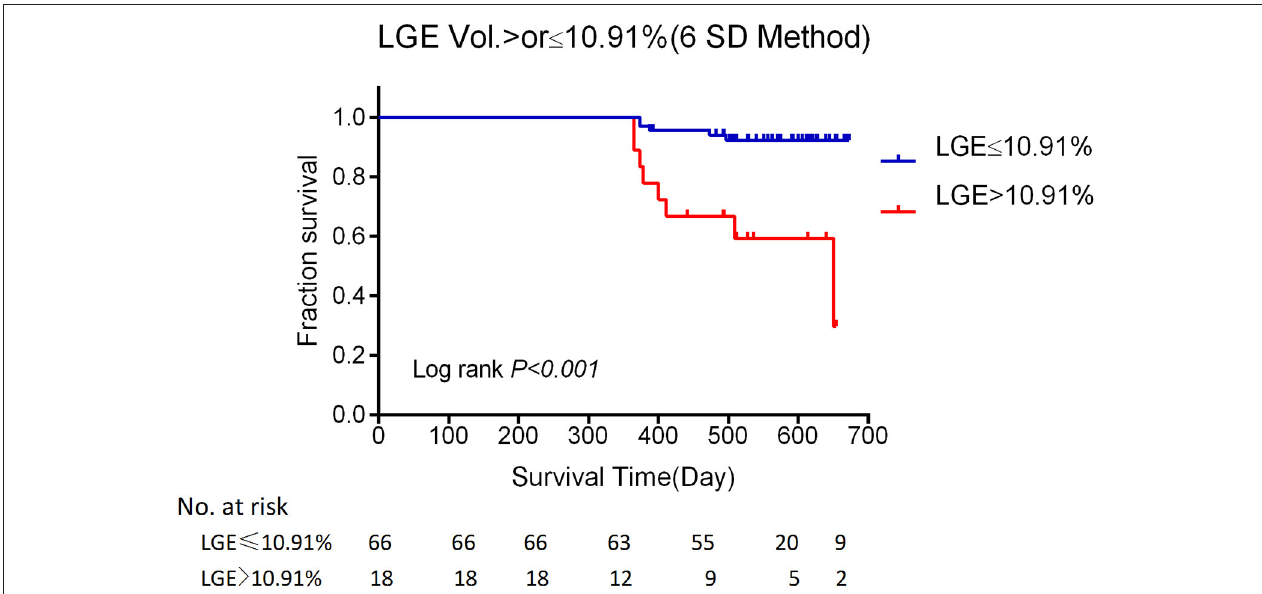
FIGURE 5 | Kaplan–Meier event-free survival curve. Kaplan–Meier analysis of freedom from major adverse cardiac events according to: LGE of > 10.91 or < 10.91% of the volume of the left ventricle, as measured using the 6SD method. (Log-rank, P < 0.001). LGE, late gadolinium enhancement; SD , standard deviation.